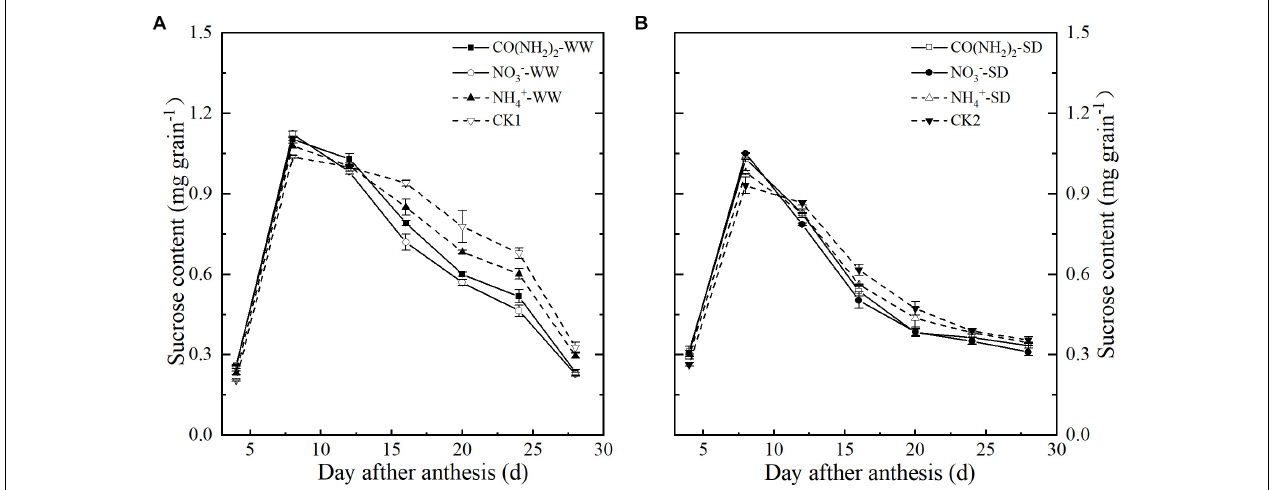
FIGURE 2 | Effect of N forms in foliar fertilizer on the sucrose content in the wheat grains [ (A) well-watered treatment, WW; (B) soil-dried treatment, SD]. Vertical bars represent ± the standard deviation of the mean ( n = 3). CO(NH 2 ) 2 , NO 3 − , and NH 4 + represent CO(NH 2 ) 2 , NaNO 3 , and NH 4 Cl, whose concentration was described in Materials and Methods. CK1 and CK2 mean that deionized water was sprayed on leaves at anthesis under well-watered treatment and soil-dried treatment, respectively.